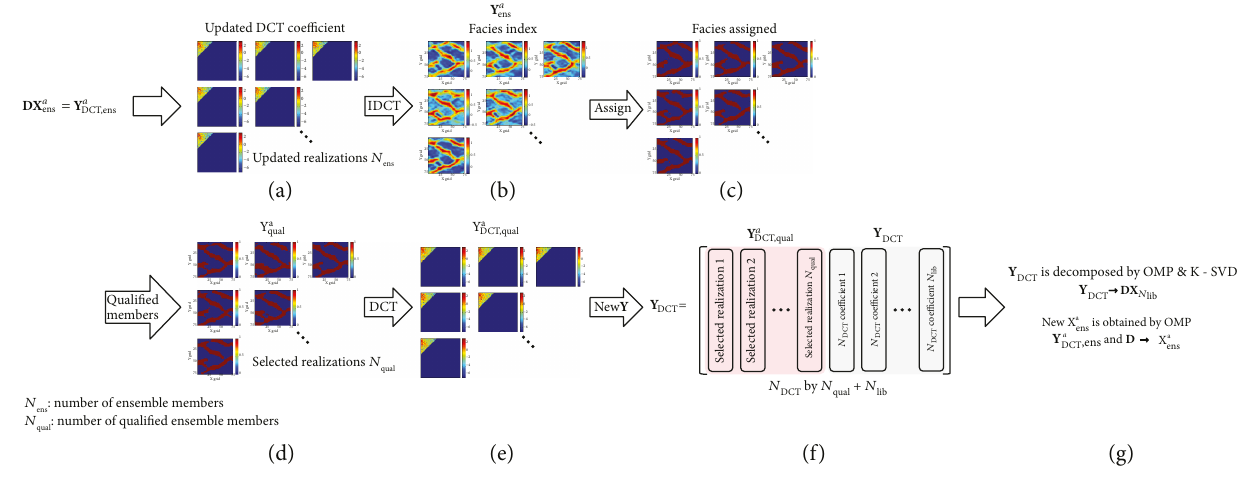
Figure 3: Update of sparse geologic dictionaries during